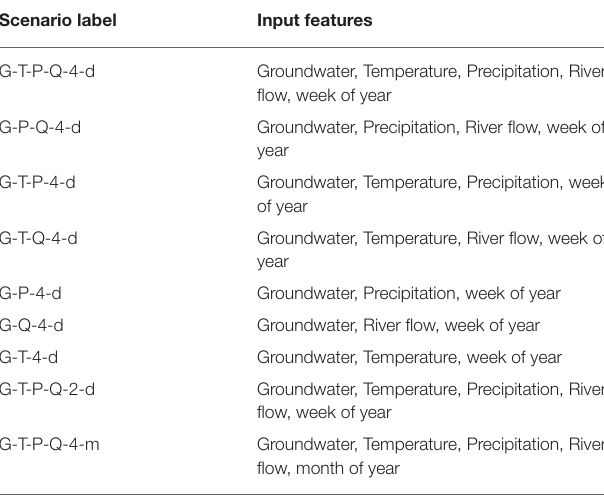
TABLE 2 | Combinations of input features for training the DL